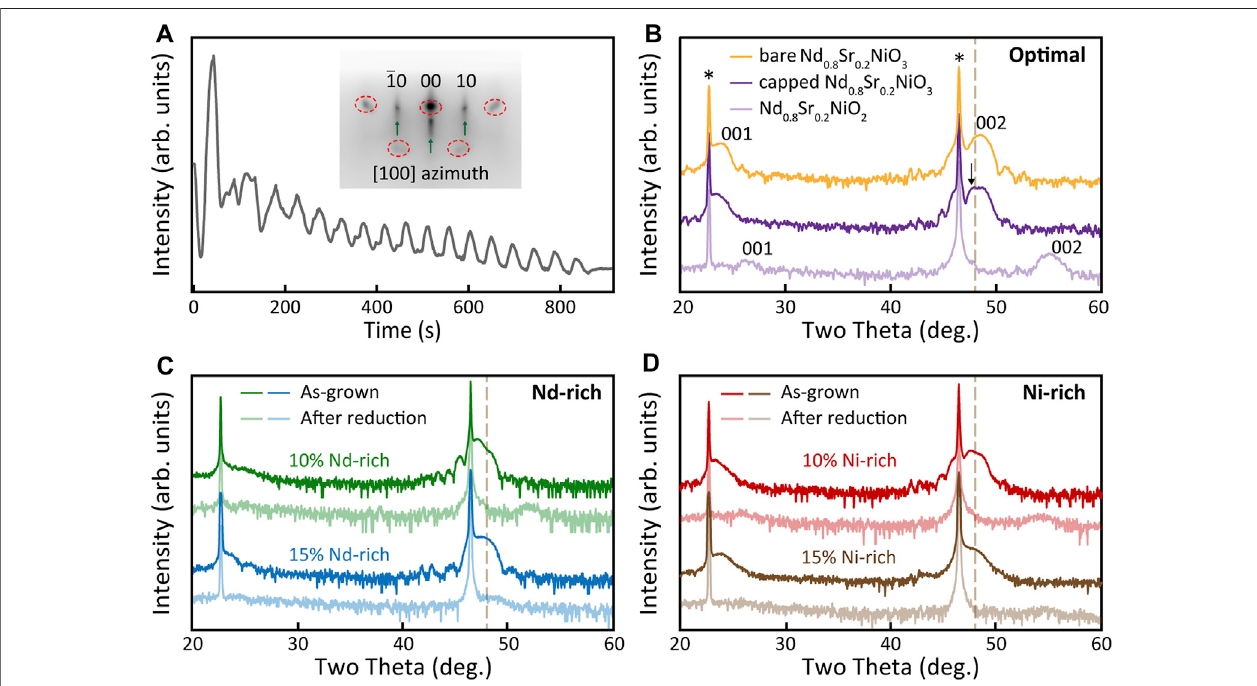
FIGURE 3 | Effect of cation stoichiometry on the reduction of Nd 1- x Sr x NiO 3 . (A) RHEED intensity oscillations and pattern (inset) of an 18 u.c. thick optimal Nd 0.8 Sr 0.2 NiO 3 fi lmgrownonSrTiO 3 substrates.Thered opendashed circlesand greenarrows indicatethediffractionsoftheimpurityphasesandtheperovskitephase ofthe fi lm,respectively. (B) High-resolution XRD2 θ - ω scansofthe nickelate fi lmsgrown underan optimal fl uxratio.TheNd 0.8 Sr 0.2 NiO 3 fi lmbefore and after capping the SrTiO 3 layer is called bare and capped Nd 0.8 Sr 0.2 NiO 3 , respectively. The dashed line represents the critical two theta values of 48 ° . (C) High-resolution XRD 2 θ - ω scans of as-grown and reduced Nd-rich Nd 0.8 Sr 0.2 NiO 3 fi lms. (D) High-resolution XRD 2 θ - ω scans of as-grown and reduced Ni-rich Nd 0.8 Sr 0.2 NiO 3 fi lms.